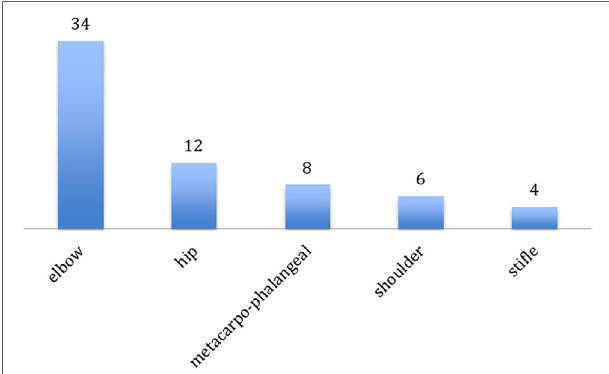
FigUre 1 | Distribution of 64 joints treated with low-dose radiation therapy in 23